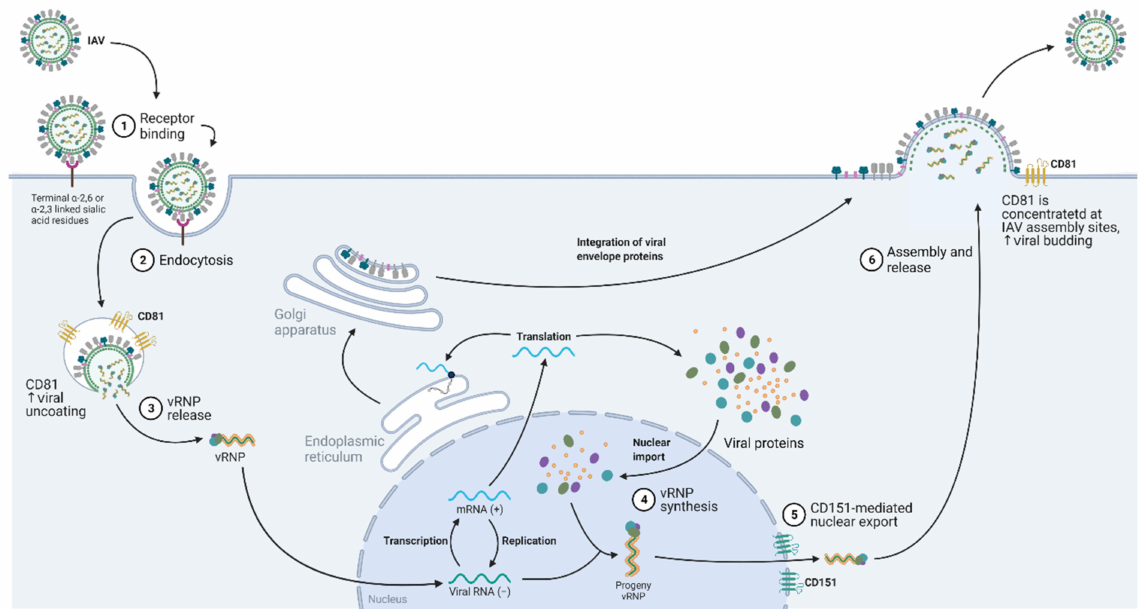
Figure 4. Diagram showing the contribution of tetraspanins in the influenza A virus replication cycle. Upon endocytosis, CD81 enhances viral uncoating, while CD151 facilitates vRNP nuclear export signaling. Abbreviations: IAV, influenza A virus; CD81, cluster of differentiation 81; CD151, cluster of differentiation 151; vRNP, viral